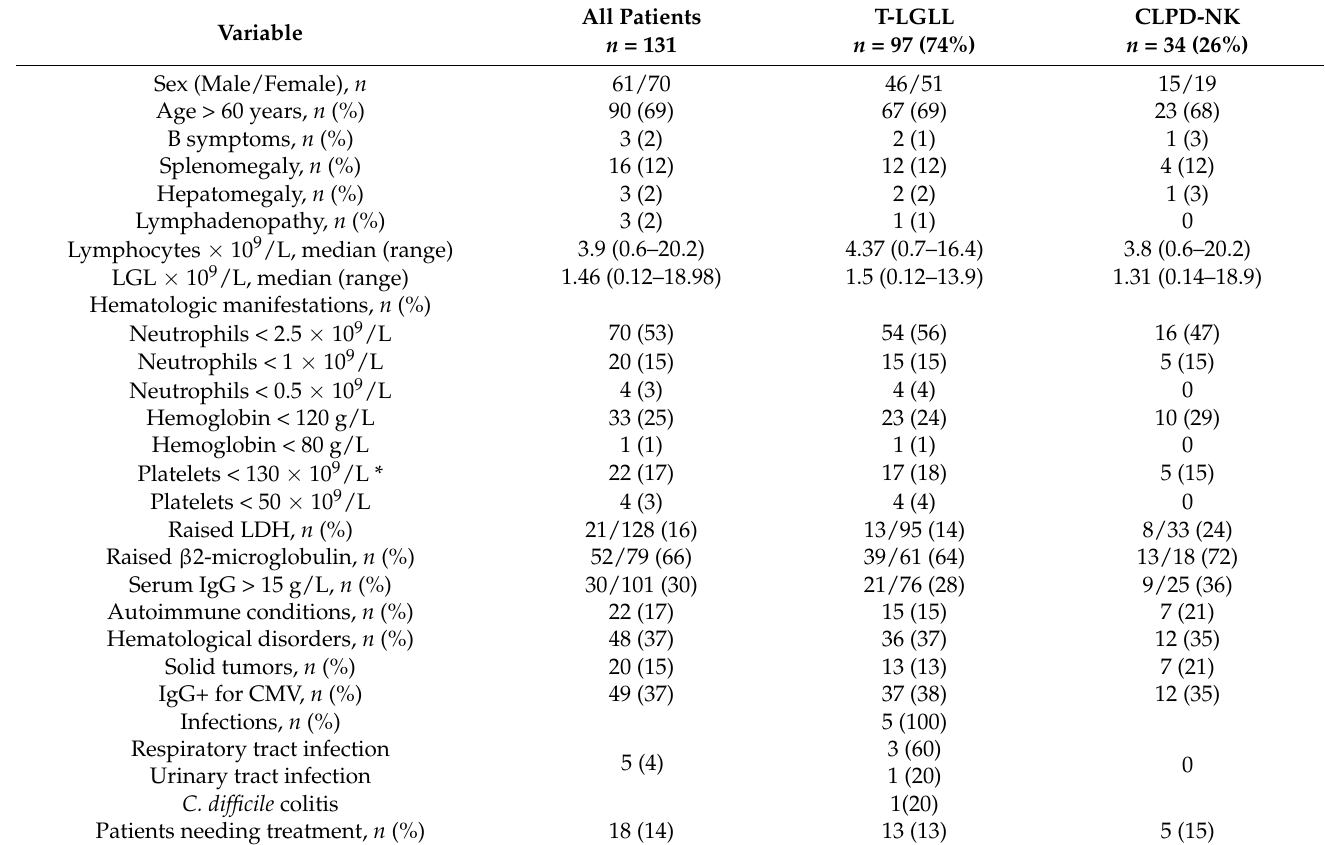
Table 1. Main clinicobiological features of the 131 patients included in the